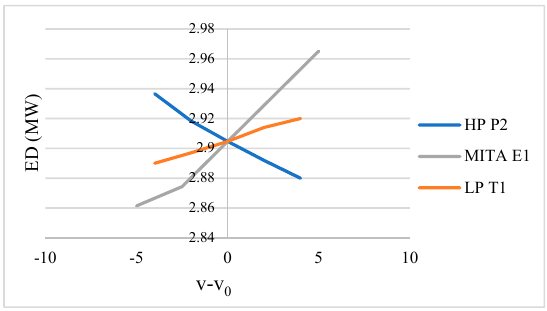
Figure 12. Exergy destruction variation with respect to step changes of variables 𝒗 𝒊